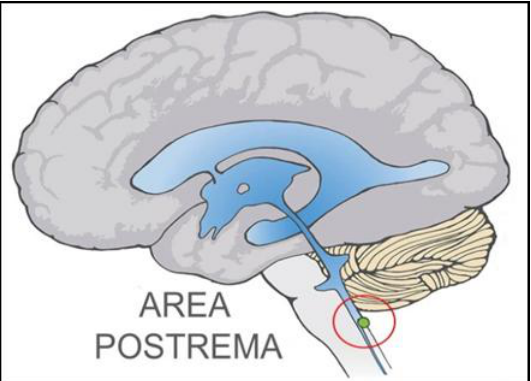
Figure 1. Area Postrema is Anatomical Marker for the Subregion of NTS of Primary Hypothetical Interest. Midline AP is the circled green structure at the lower right. The subregion of the NTS that borders the midline AP is not shown in this sketch, but rather in subsequent figures.